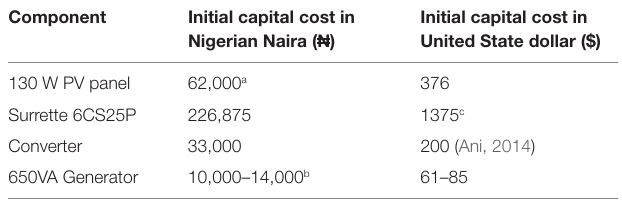
TaBle 4 | capital cost of the energy system